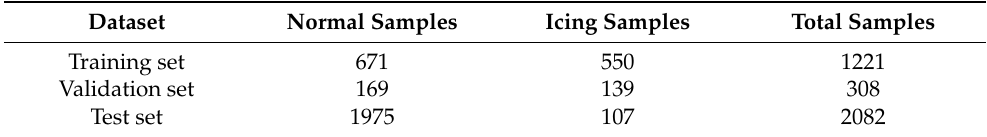
Table 2. Detailed datasets